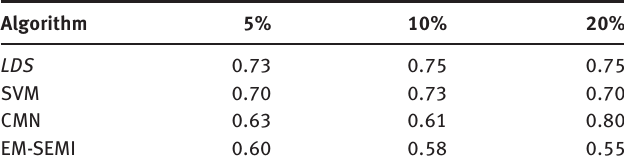
Table 4. Performance Results on PC1.